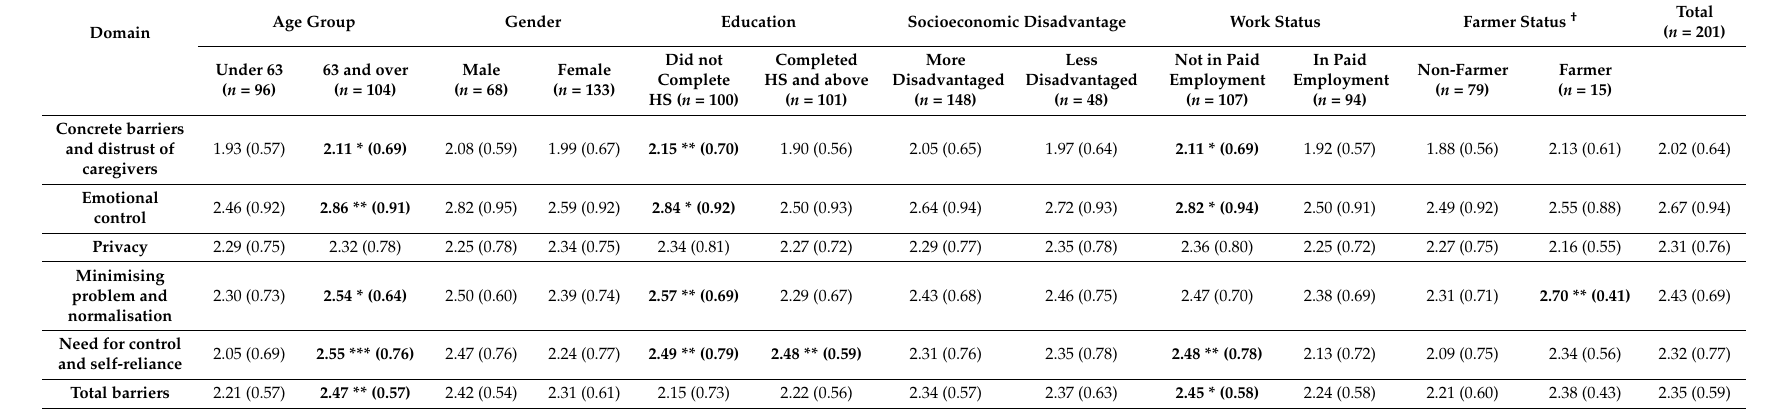
Table 2. Mean domain barrier scores # (SDs), by demographic factors.